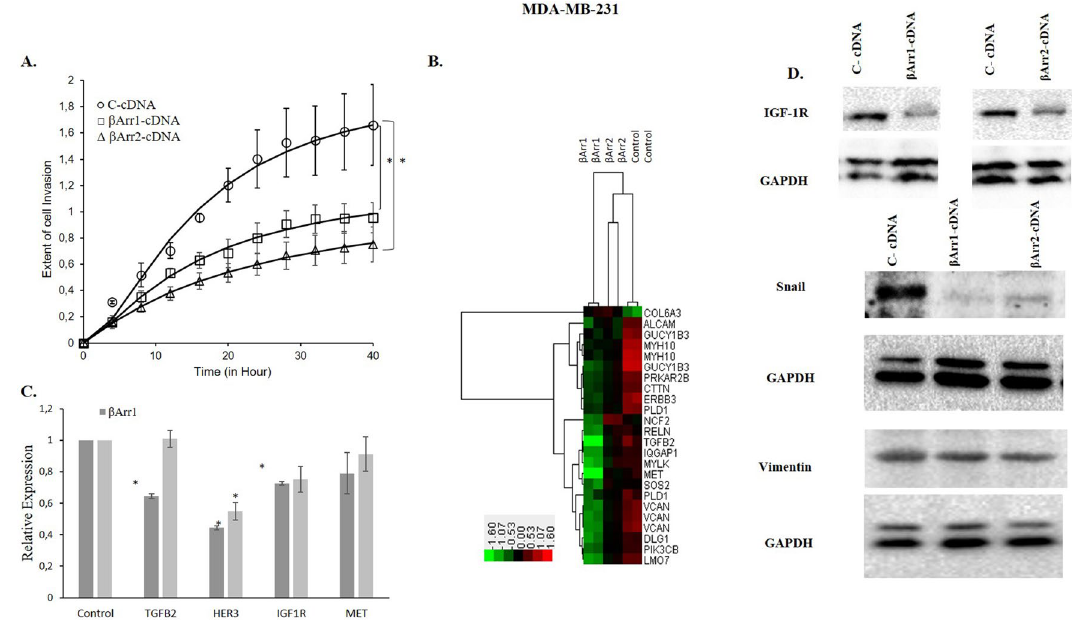
Figure 8. Overexpression of βArr1 or βArr2 and decreased cell invasion in MDA-MB-231. Invasion was significantly reduced in βArr1- or βArr2-cDNA transfected MDA-MB-231 cells. ( A ) Invasion of C (control- cDNA)-, βArr1- or βArr2-cDNA transfected MDA-MB-231 was monitored continuously using an xCelligence Real-Time Cell Analyzer in Matrigel coated CIM-plates. The cells were seeded in the upper chamber of the plates and impedance measurements of cell invasion were recorded at 40 h. Y axis shows changes in impedance as a measurement of the extent of cell invasion. Data are presented as mean ± standard error of the mean; n = 4–5; * = p < 0.05 versus C-cDNA. ( B ) Two-way hierarchical clustering analysis was performed for the clustering of samples according to both genes (right panel) and sample types (top panel). The heatmap was visualized by Treeview. Hierarchical clustering performed with the motility and invasion related genes obtained from the microarray analysis successfully separated βArr1 and βArr2 overexpressed cells from control cells. Green boxes represent downregulation, red boxes are used for upregulation and black means no change in the gene expression levels and the expression levels vary between − 1.6 and 1.6 folds in log2 scale. ( C ) The expression profiles of selected motility and invasion related genes were determined by qRT-PCR experiments and expression of TGFβ2, HER3, IGF1R was significantly down regulated. Data are presented as mean ± standard error of the mean (* p < 0.05 versus C-cDNA). ( D ) The protein expression levels of mesenchymal markers Snail, Vimentin and IGF-1R were detected by Western blot analysis. IGF-1R and Snail were downregulated in βArr1- or βArr2 overexpressed MDA-MB-231 cells while Vimentin expression stayed